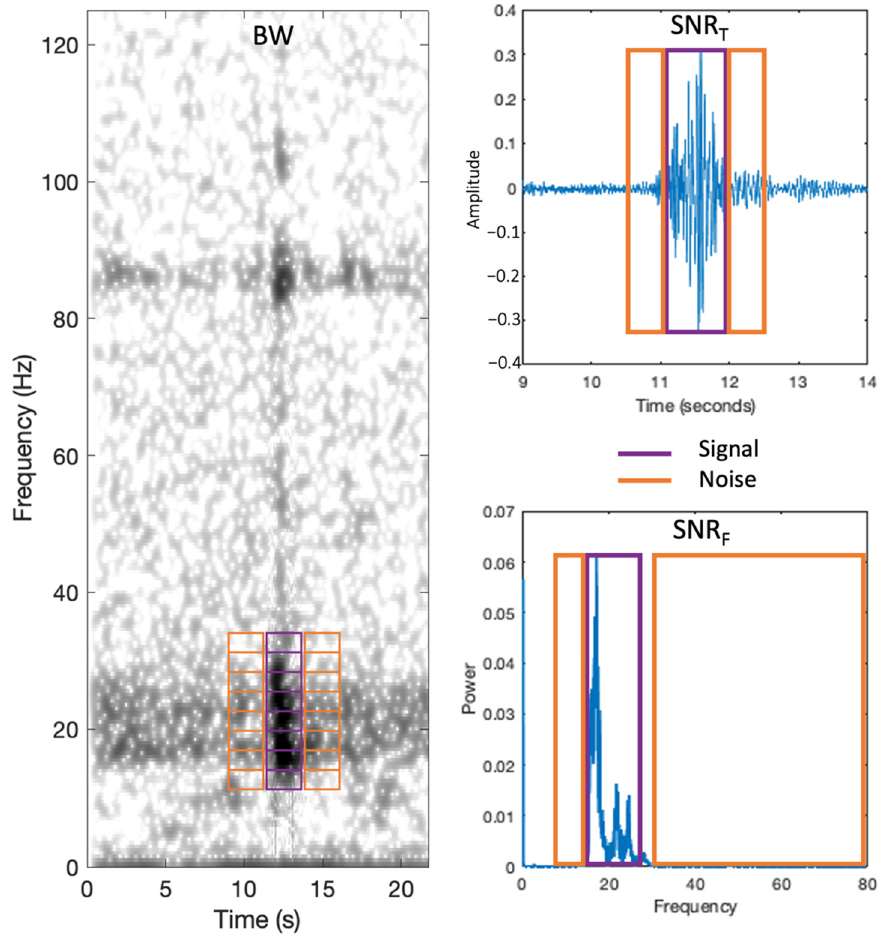
Figure 3. Illustration of the temporal-spectral appearance of a fin whale 20 Hz-Pulse and the presented methods to calculate the SNRs and the bandwidth of presumed 20 Hz-Pulses: the bandwidth (BW), the temporal SNR (SNR T ), and the spectral SNR (SNR F ). Purple boxes represent the power/amplitude of the signal of interest and orange boxes represent the power/amplitude of the adjacent noise.